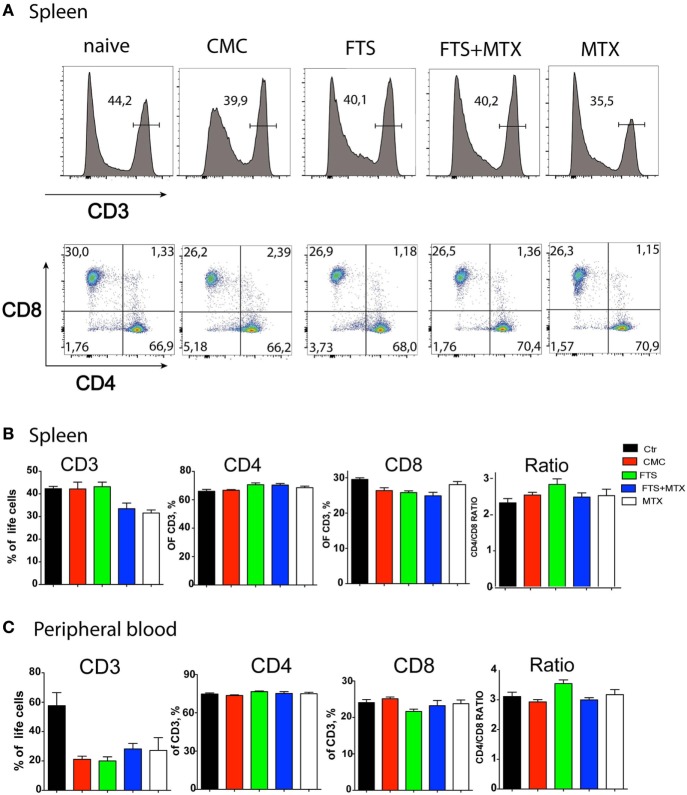
Effects of farnesylthiosalicylic acid (FTS) therapy on splenic and peripheral blood T cell populations. At study termination, single cell suspension of spleens (A,B) and peripheral blood (C) from the various groups of treated rats (n = 8 per group) were analyzed by flow cytometry for CD3+ CD4+, and CD8+ T cell frequencies. Samples were acquired on a FACSAria instrument (~50,000 single cell events per sample) and analyzed using the FlowJo software. The results shown represent a typical experiment out of >5 performed.